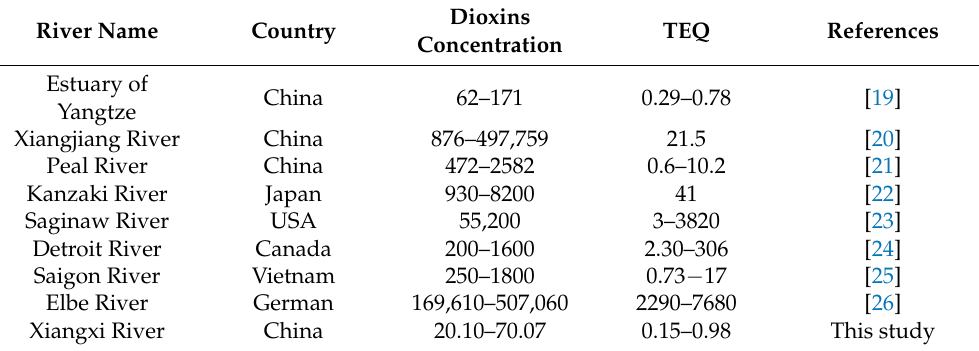
Table 3. Concentrations of dioxins in different rivers (pg/g